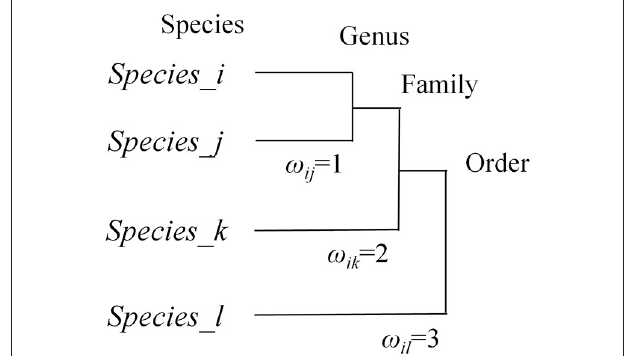
FIGURE 1 | Definition of taxonomic